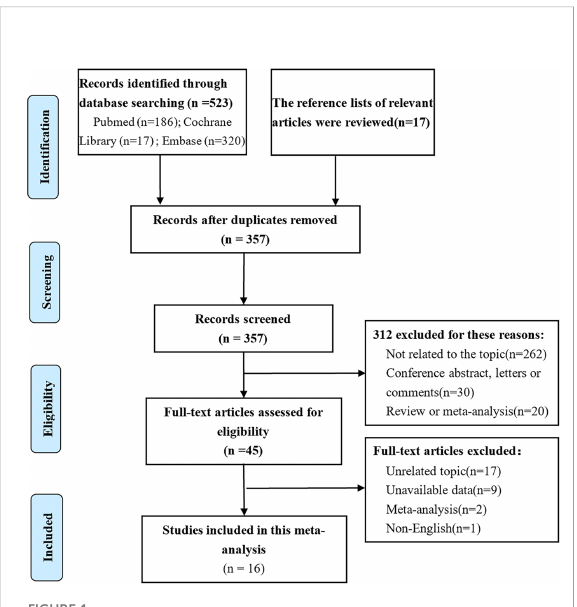
FIGURE 1 PRISMA fl ow diagram outlining the literature search